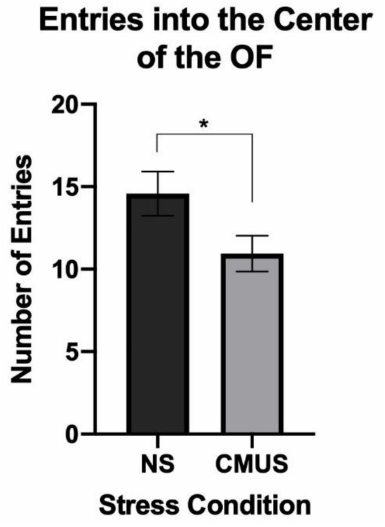
Figure 4. Number of entries into the center of the OFT. Mice undergoing CMUS made significantly fewer entries into the center of the OFT as compared to NS mice (* p < 0.05).